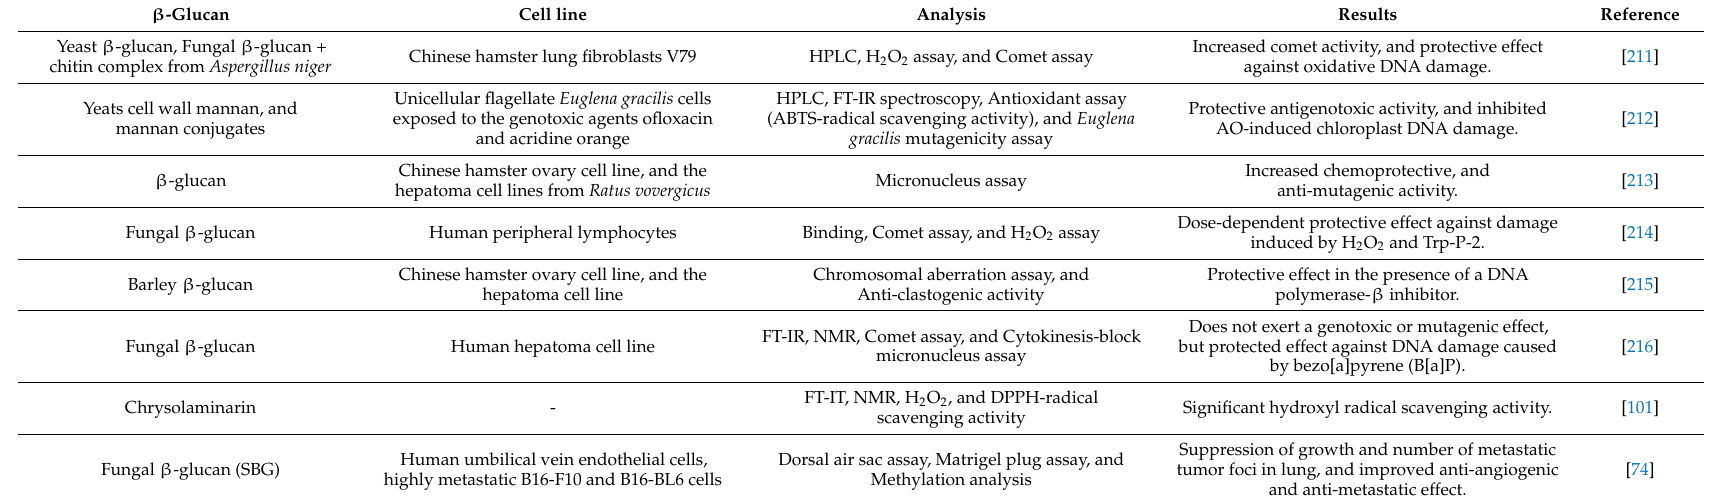
Table 15. Antigenotoxicity/antimutagenicity/antioxidative effects of β -glucans—in vitro